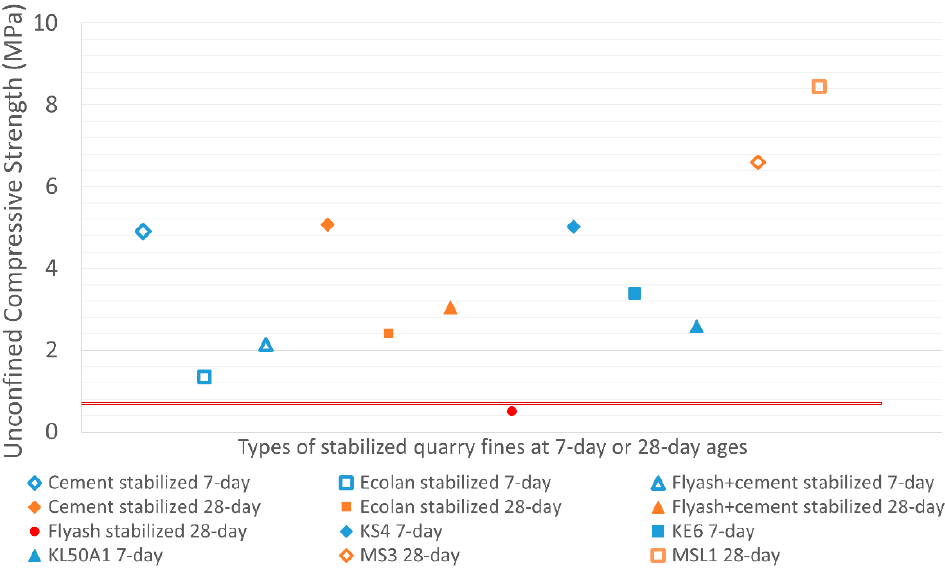
Figure 6. Average unconfined compressive strength of stabilized quarry fine specimens.